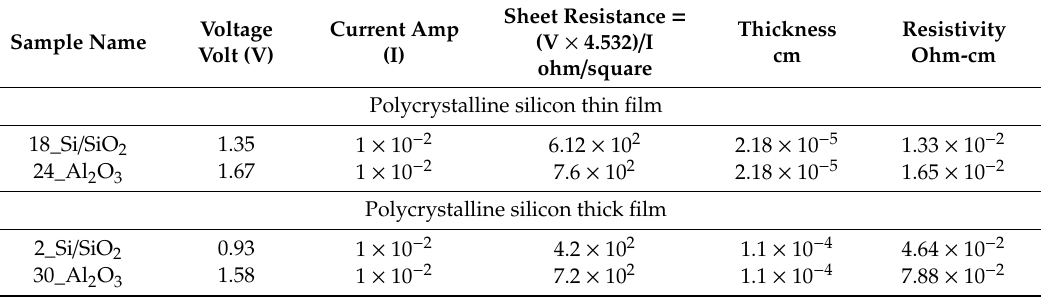
Table 2. Resistivity of boron-doped silicon film on Si / SiO 2 and Al 2 O 3